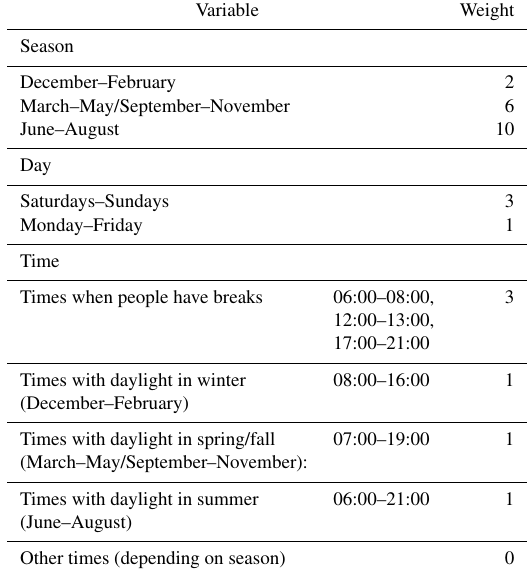
Table 3. Weights assigned to specific seasons, days and times of the day for the random selection of data points for Crowd52 and Crowd12. The weights for each hour were multiplied and nor- malised. We then used them as probabilities for the individual hours. For times without daylight the probability was set to